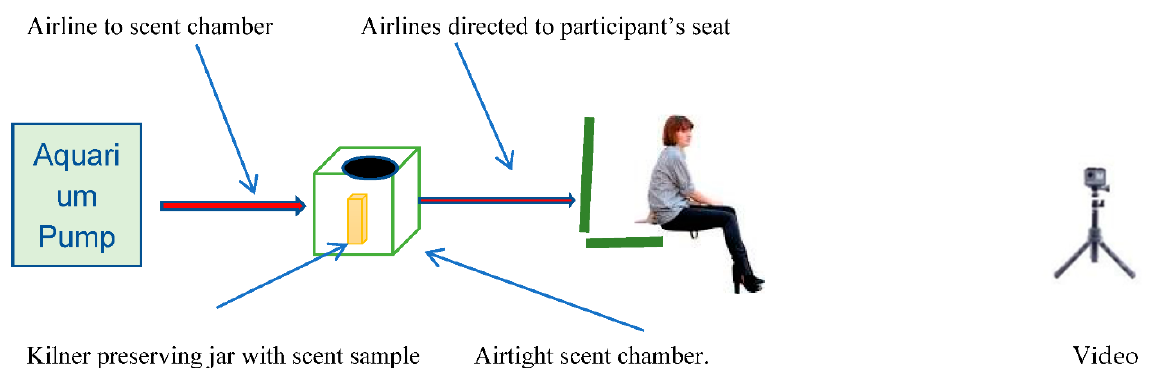
Figure 2. A schematic drawing showing how the remote odour delivery mechanism (RODM) was used.